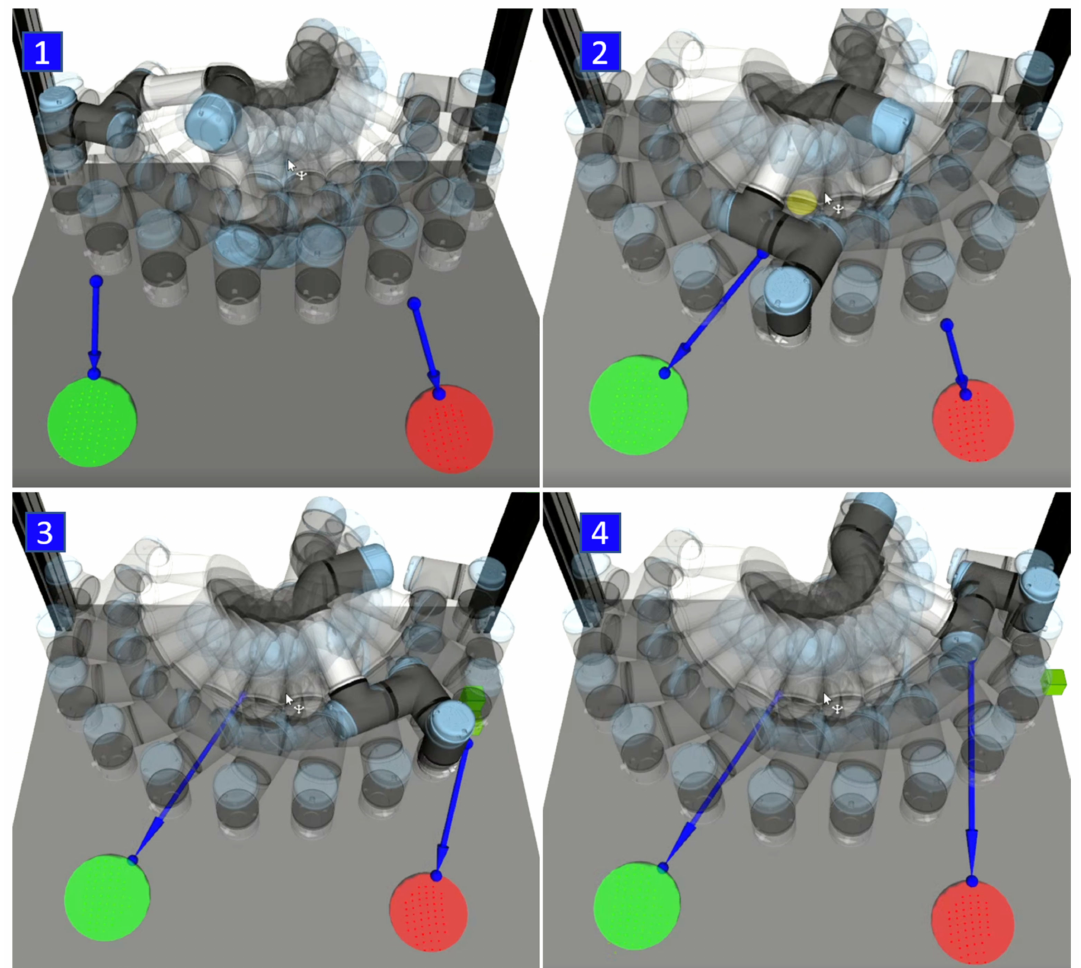
Figure 10. Example of how collision vector changing during motion sequence: robot moving from left to the right ( 1 – 4 ), collision vector is depicted by a blue arrow, HMIs are represented by green and red